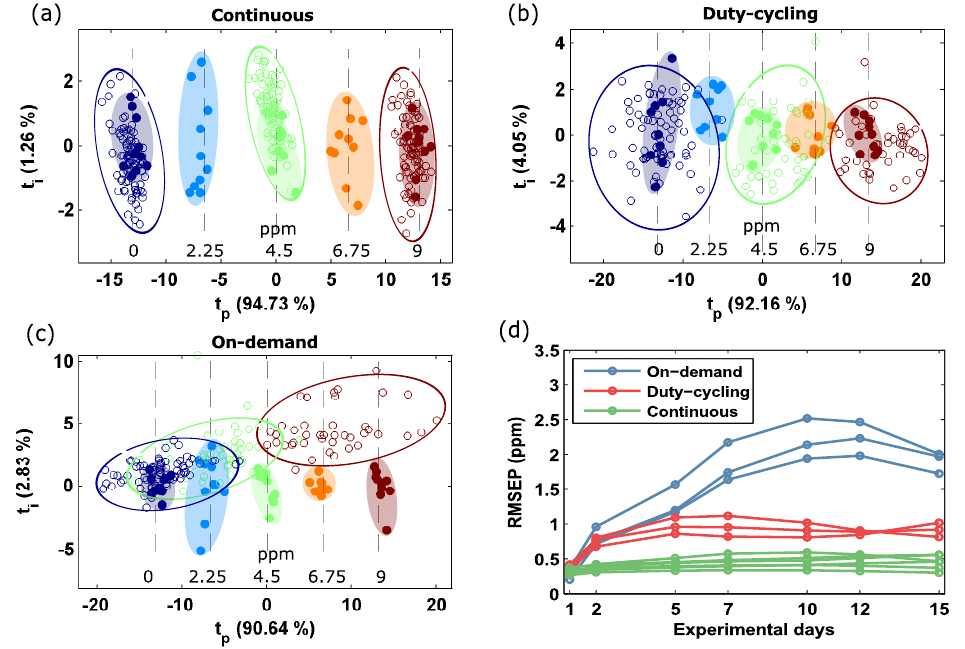
Figure 6. Score plot of the orthogonal Partial Least Squares (PLS) models obtained from one sensor of each group under continuous calibration. The title of the subplot indicates the target operating mode: ( a ) continuous, ( b ) duty-cycling, and ( c ) on-demand. The filled and open circles represent the calibration and validation observations, respectively. Hand drawn ellipses cluster observations of the same concentration level. The concentration (ppm) is indicated in the text at the bottom of the figure. ( d ) Temporal stability of each operating